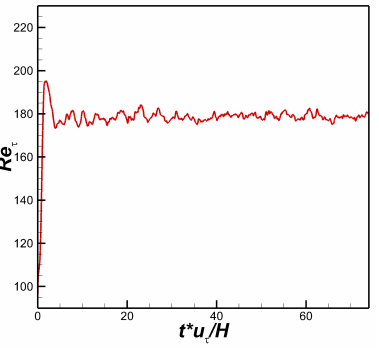
Figure 7. Time histories of friction Reynolds number at Re τ = 180 by